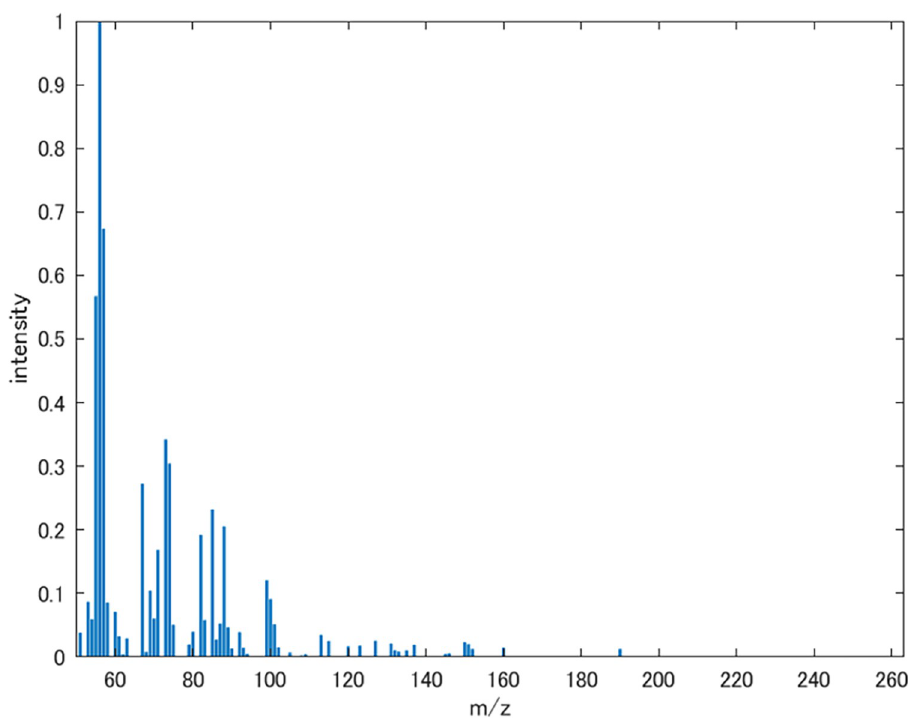
Fig 12. Mass spectrum obtained by applying Algorithm 1 in S1 Fig to the explored mass spectrum feature in the experiment for ‘sweet’.